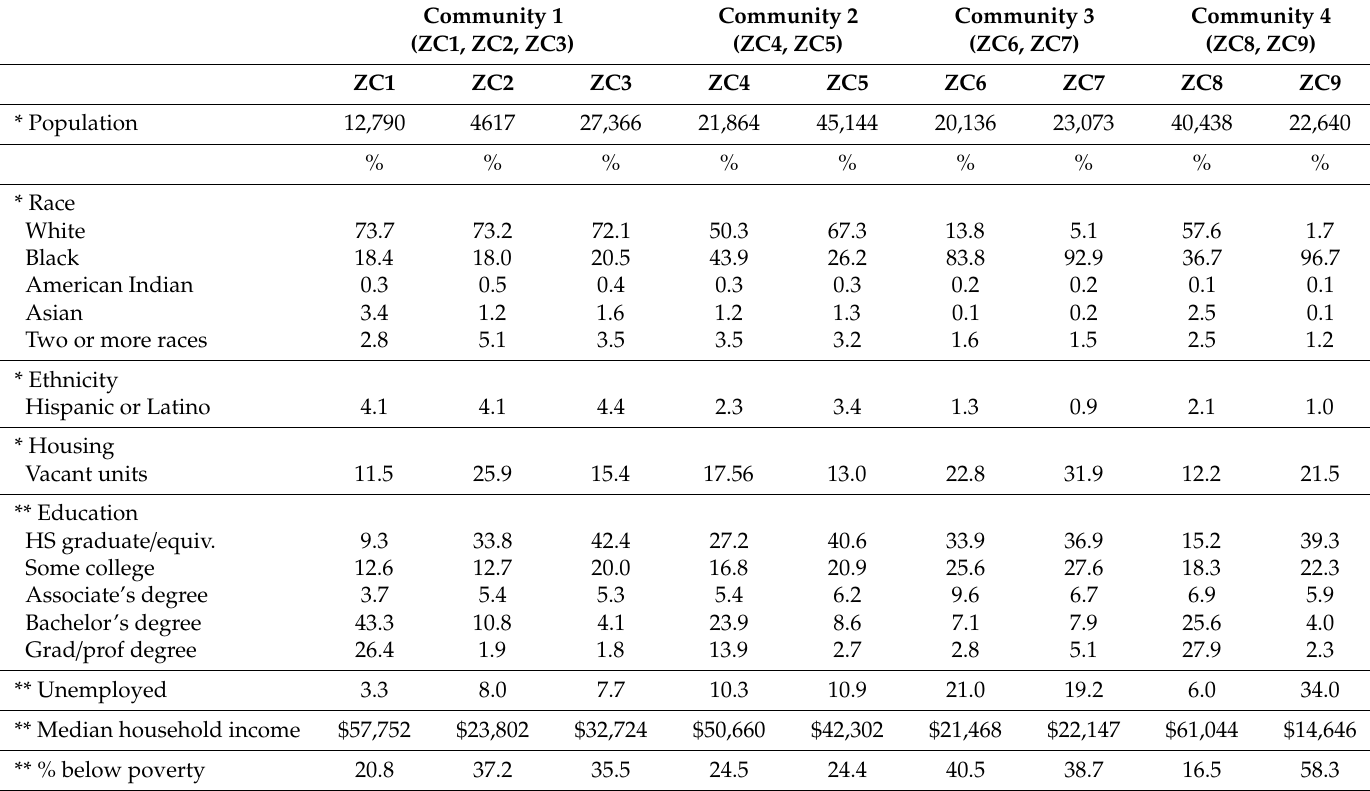
Table 1. Community